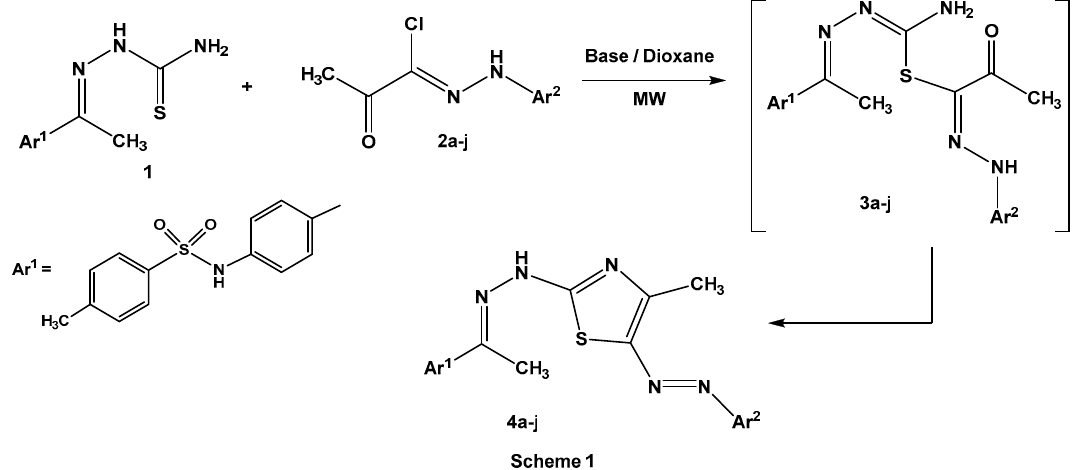
Table 2. Effect of the nature of basic catalyst on the yield of the products 4a – j .